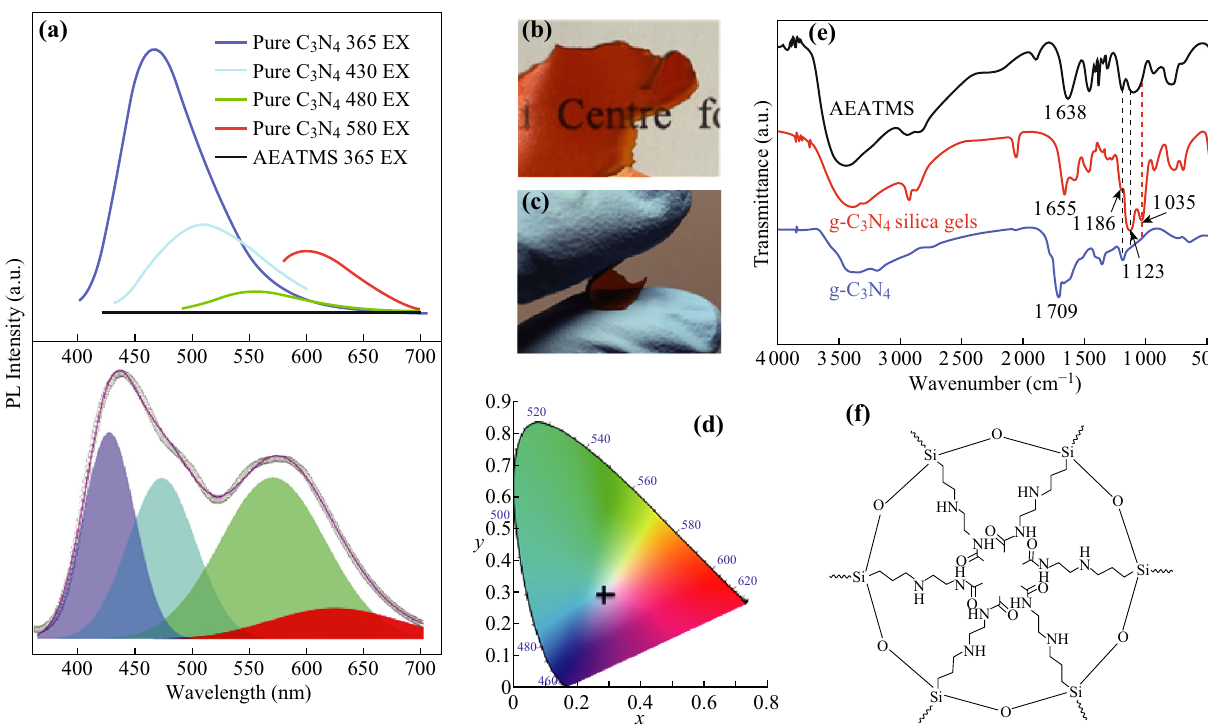
Fig. 10 a Photoluminescence spectrum of the g-C 3 N 4 /silica gels excited at 365 nm displaying four peaks (430, 480, 580, and 627 nm) in the visible regime. b , c Photographs of a free-standing g-C 3 N 4 /silica-gel membrane, displaying both good transparency b and flexibility c . d CIE- 1931 chromaticity diagram showing the emission from the typical g-C 3 N 4 /silica gels (marked by the black cross ) excited at 365 nm. e FTIR spectra of AEATMS, g-C 3 N 4 -silica gels, and g-C 3 N 4 particles. f Schematic drawing of an AEATMS-capped g-C 3 N 4 particles in the g-C 3 N 4 /silica gels. Reproduced with permission from Ref. [119]. Copyright 2016